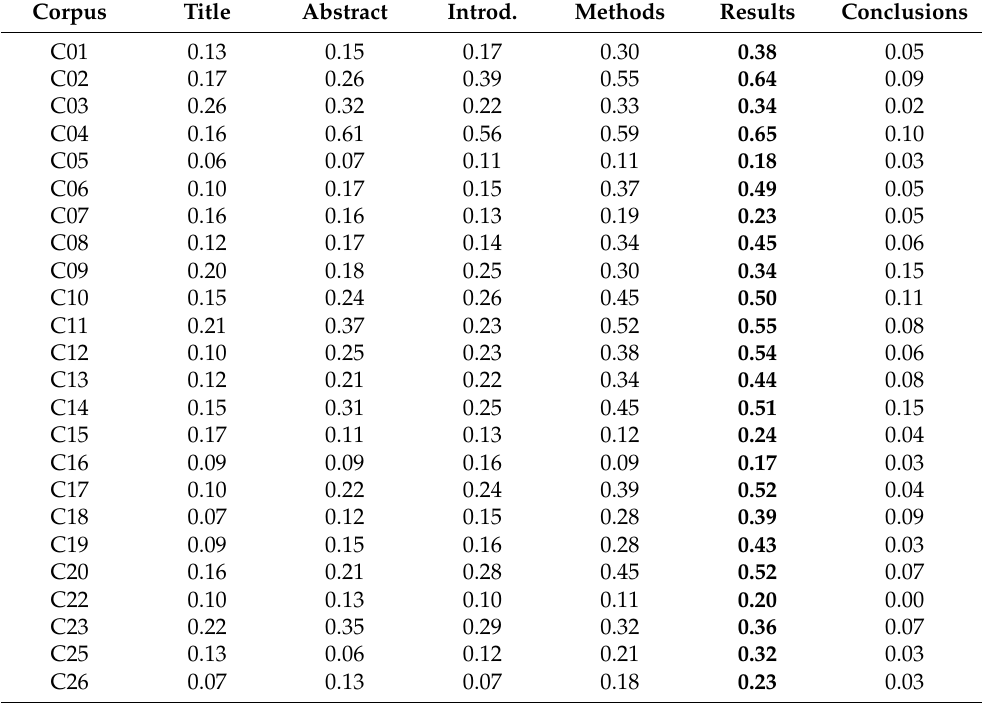
Table 6. Kappa values obtained by the base classifiers on the different views (text sections). Corpus Introd. Methods